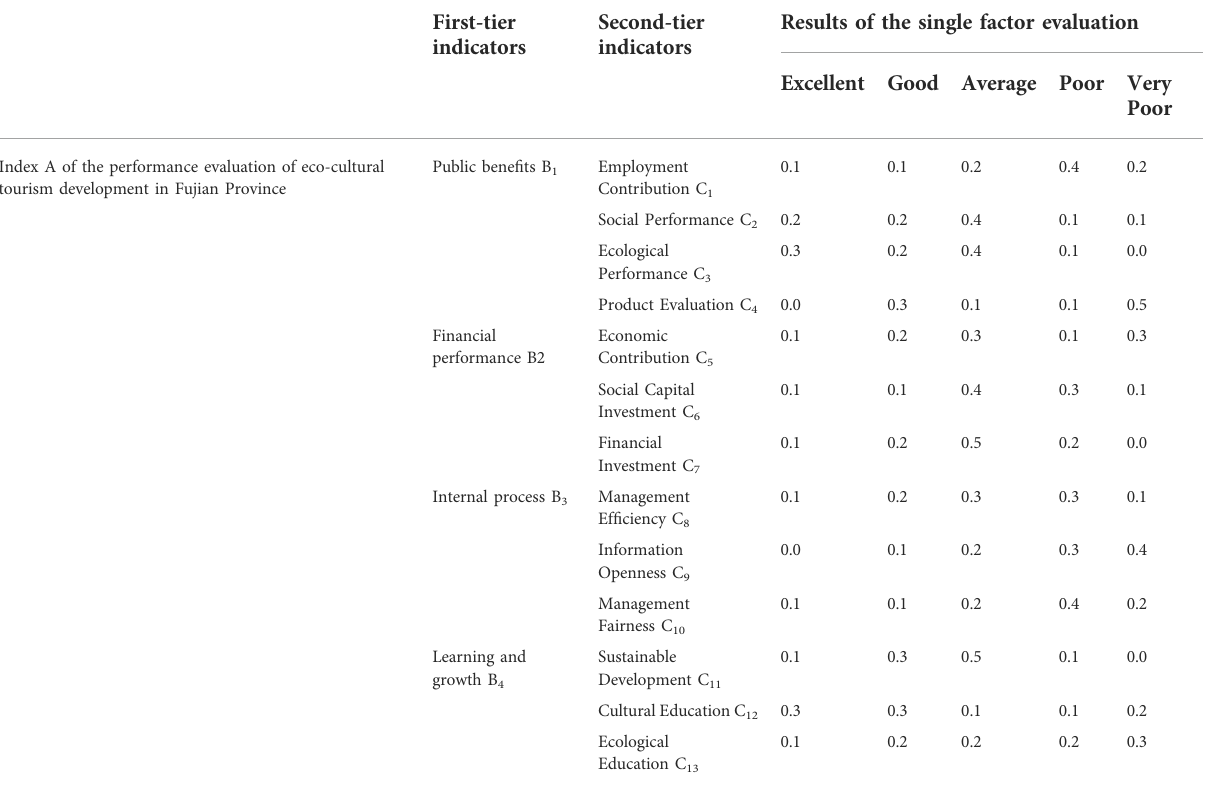
TABLE 2 Evaluation indicators and results of the single factor evaluation of the eco-cultural tourism development in Fujian Province.